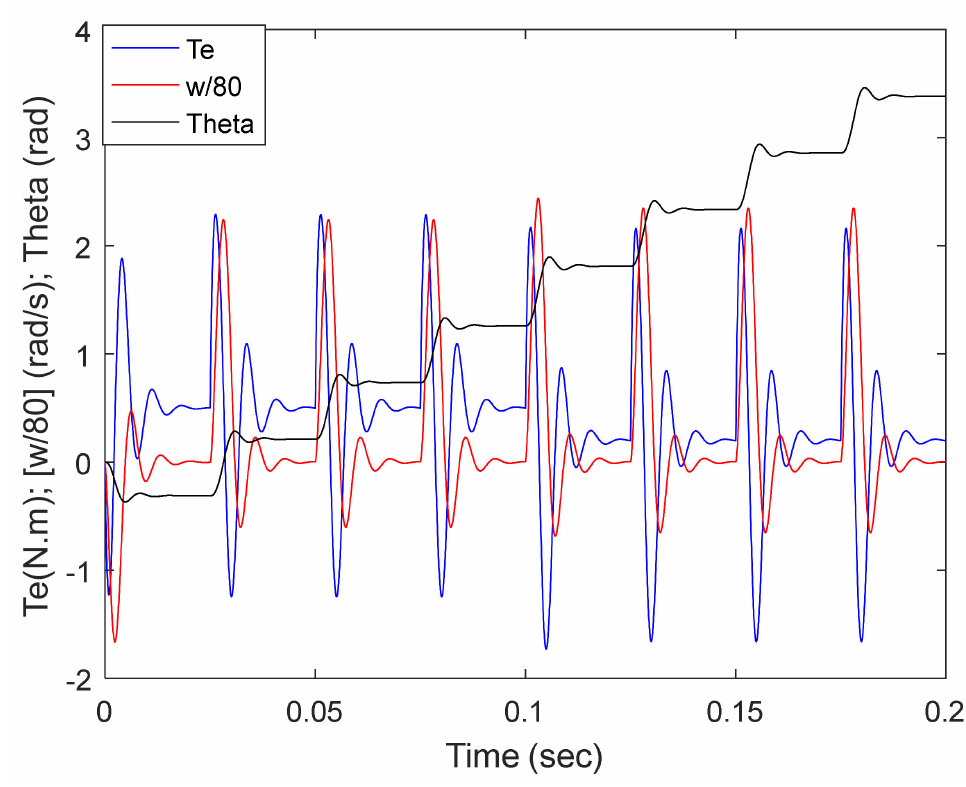
Figure 13. Characteristic of stepper motor at period signal 0.1 s and changing load torque from 0.5 to 0.2